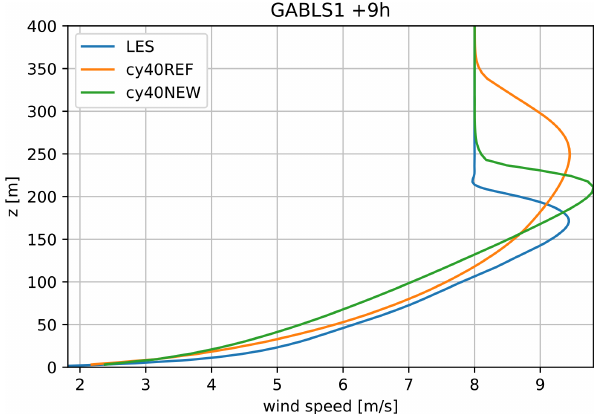
Figure 15. GABLS1 wind profile at the ninth simulation hour of LES model DALES (blue), cy40REF (orange), and cy40NEW (green). SCM runs use 64 levels with the lowest and highest model levels at 3 and 403m, respectively. Note that results for GABLS1 with several LES models in Beare et al. (2006) reveal a spread in the height of the wind maximum, ranging from 175 to 200m. The lat- ter height and the corresponding LES profile in Beare et al. (2006) correspond well with